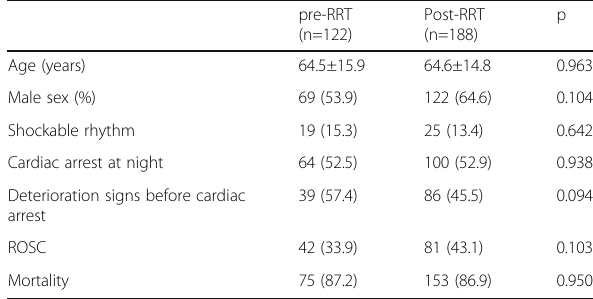
Table 1 (abstract 0315). Cardiac arrest profile before and after rapid response team implementation